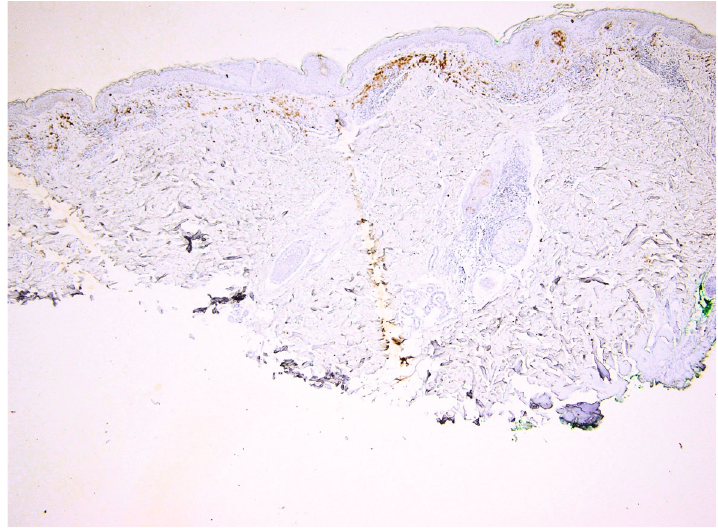
Figure 9: FOXP3 expression in lymph cells from an area of regressed melanoma. FOXP3 immunoassay, magni fi cation 100x.